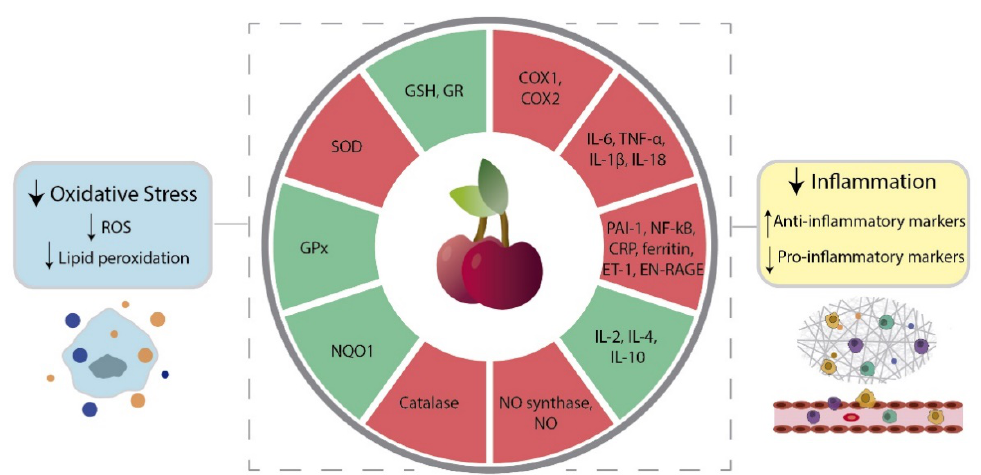
Figure 1. Sweet cherry modulation of oxidative stress and inflammation. Sweet cherry extracts reduce oxidative stress by decreasing the production of reactive oxygen species (ROS), namely nitric oxide (NO) and lipid peroxidation. This was accompanied by the decreased activity of nitric oxide (NO) synthase, up-regulation of glutathione (GSH), and altered expression of several enzymes involved in the antioxidant defense, such as glutathione reductase (GR), glutathione peroxidase (GPx), NAD(P)H quinone oxidoreductase (NQO1), catalase, and superoxide dismutase (SOD). The anti-inflammatory effect of sweet cherries is achieved by both inducing anti-inflammatory markers whereas inhibiting the pro-inflammatory ones. Identified targets include the anti-inflammatory (interleukin (IL)-2, -4 and -10) and pro-inflammatory (IL-6, - 1β and -18) cytokines tumor necrosis factor (TNF)- α , cyclooxygenase (COX) 1 and COX2, nuclear factor kappa-light-chain-enhancer of activated B cells (NF- к B), C-reactive protein (CRP), epidermal growth factor (EGF), endothelin-1 (ET-1), extracellular newly identified receptor for advanced glycation end-products binding protein (EN-RAGE), ferritin and plasminogen activator inhibitor-1 (PAI-1). Green and red circle sections mean activation and inhibition, respectively.